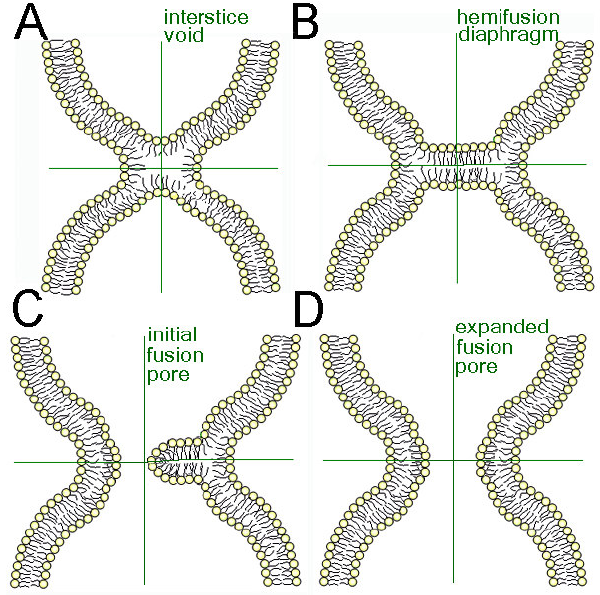
FIGURE 3. Hemifusion diaphragm (HD) in membrane fusion. (A) Voids in the junction of fusing membranes create steep energy barriers. (B) Membrane tilt and formation of HD lower the energy barrier. (C) Formation of a fusion pore begins when the HD’s radius expands beyond the membrane’s thickness generating a rupture near the HD’s rim. This fusion pore may flicker in and out of existence before becoming stable. (D) As the HD continues to expand, the pore becomes large enough for the RNA/DNA to pass through